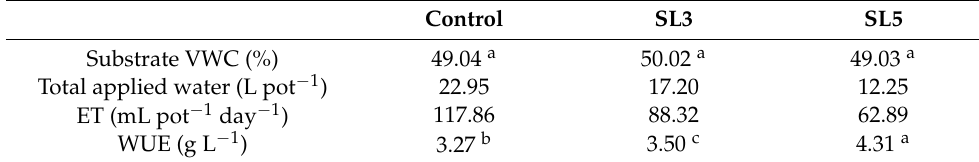
Table 2. Average volumetric water content (VWC) of the substrate, total applied water (water consumption), daily evapotranspiration (ET), and water use efficiency (WUE). Control (1.8 dS m − 1